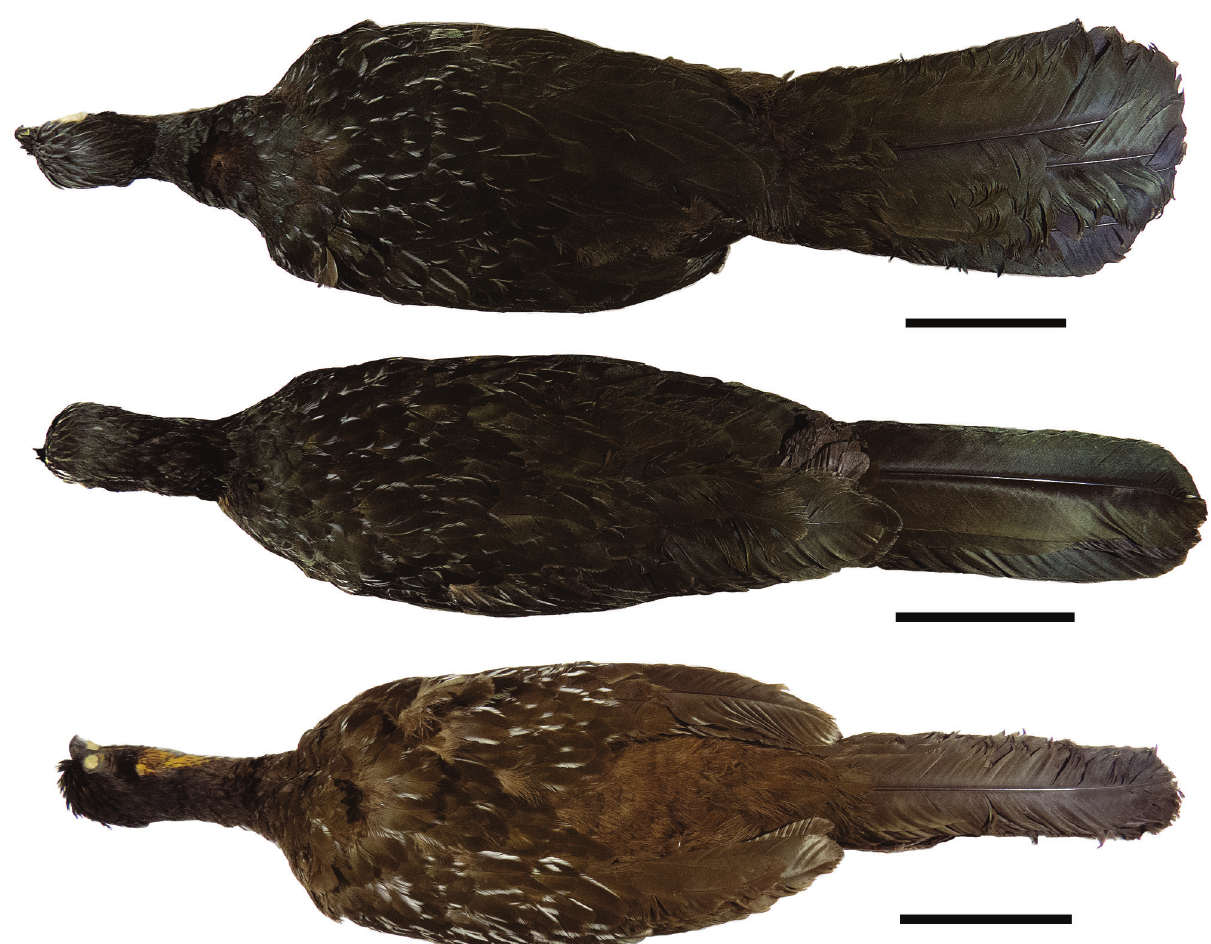
Figure 4. From top to bottom, dorsal view of P. o. bronzina (MZUSP 49384, São Paulo, southeastern BR), P. o. obscura (MACN 48384, Corrientes, northeastern ARG), and P. o. bridgesi (MACN 8148a, Tucumán, northern ARG). Scale bars: